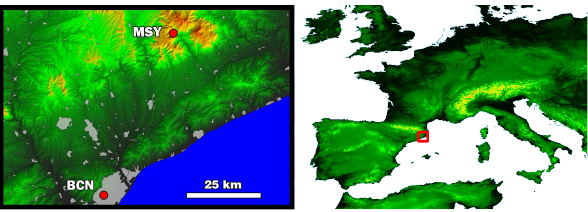
Fig. 1. Location of the urban Barcelona (BCN) and rural Montseny (MSY) measurement